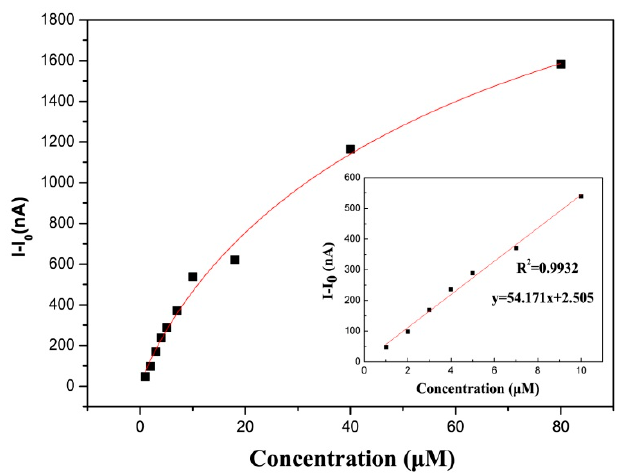
Figure 5. The curve of Pt-IrO 2 /TiO 2 NTs/Ti for the detection of different concentrations for GSH.